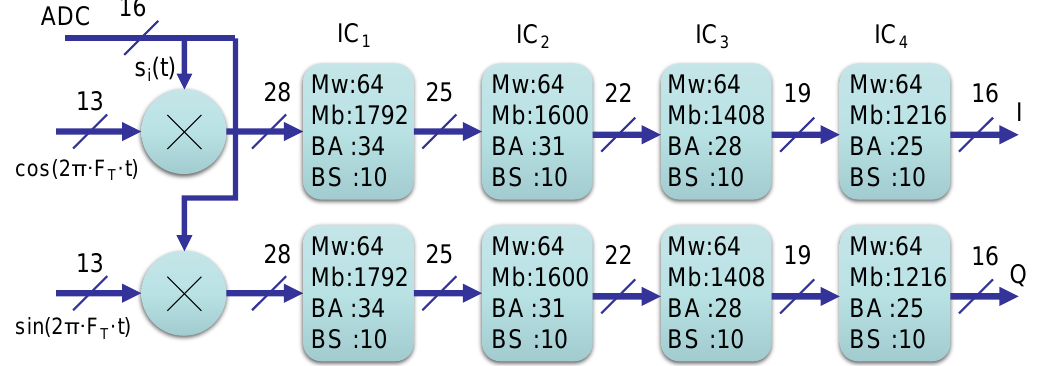
Figure 8. Architecture of the data-adaptive demodulator. IC cells report the memory words (Mw), the memory bits (Mb), the accumulator width (BA), and the barrel-shifter (BS) positions. The bus-widths in input and output of each IC cell are reported as well.